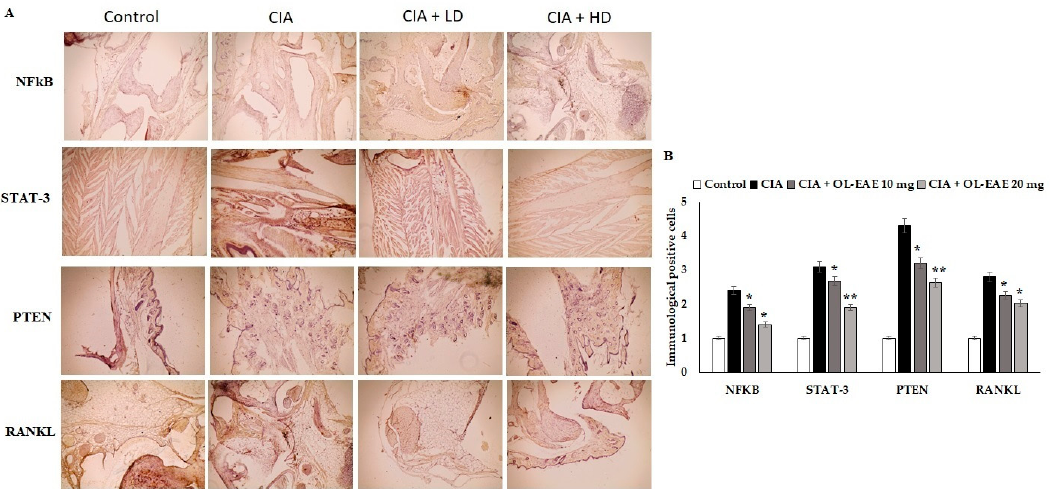
Figure 4. Effects of EAE on NF-kB, STAT-3, PTEN, and RANKL expression in CIA-induced arthritis mice model. ( A ) Representative photomicrographs of immunohistochemical analysis of NF-kB, STAT-3, PTEN, and RANKL in paw sections from control, CIA, low-dose CIA/EAE, and high-dose CIA/EAE groups after 4 weeks. IHC counterstained with Mayer’s hematoxylin, X: 400, bar: 50 μ m. ( B ) Histogram plot showing the scores of NF-kB, STAT-3, PTEN, and RANKL represented as fold changes. The data presented are the median ( n = 6) and * p < 0.05 and ** p <0.001 when comparing CIA groups with EAE-treated group using Student’s T-test ( n = 6).